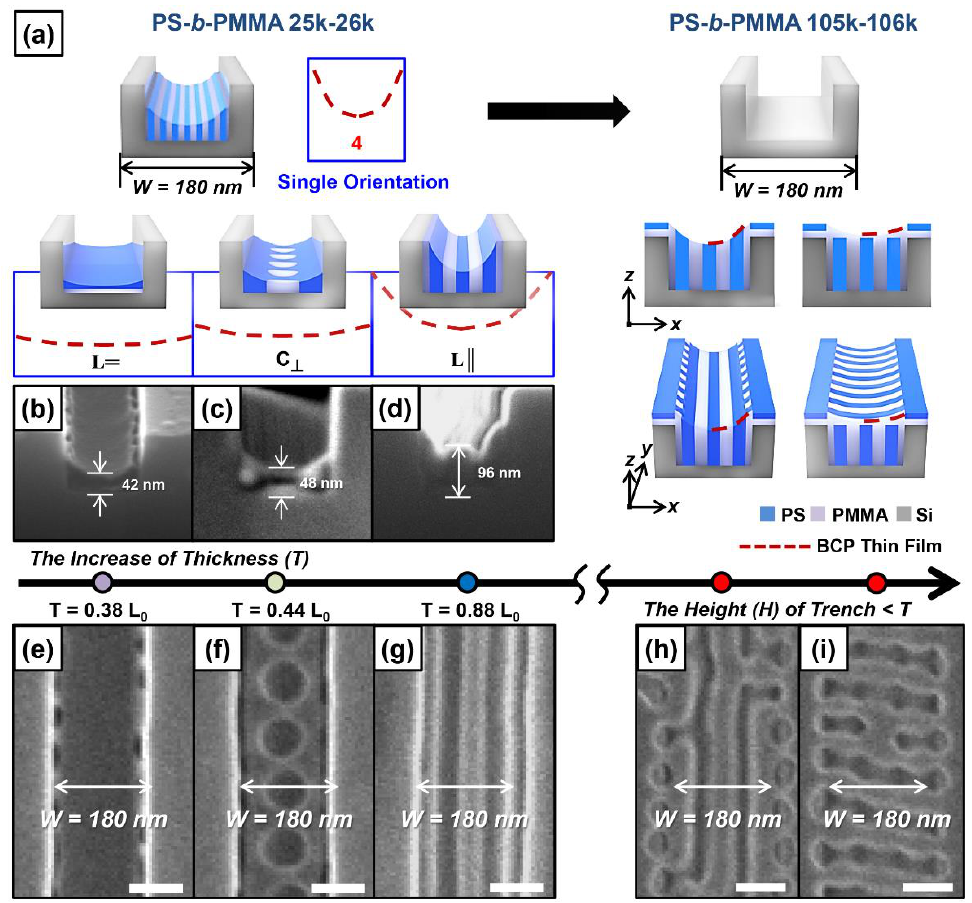
Figure 2. Single orientation of a lamella-forming BCP (PS- b -PMMA, M n = 105 – 106 kg/mol, L 0 = 109 nm) thin film inside a silicon trench (scale bar = 100 nm). ( a ) Schematic illustration of various single orientations of lamella-forming BCP thin films. Cross-view ( b–d ) and top-view ( e – i ) SEM images of BCP thin films inside a silicon trench (T = 42, 48, 96, 244, and 274